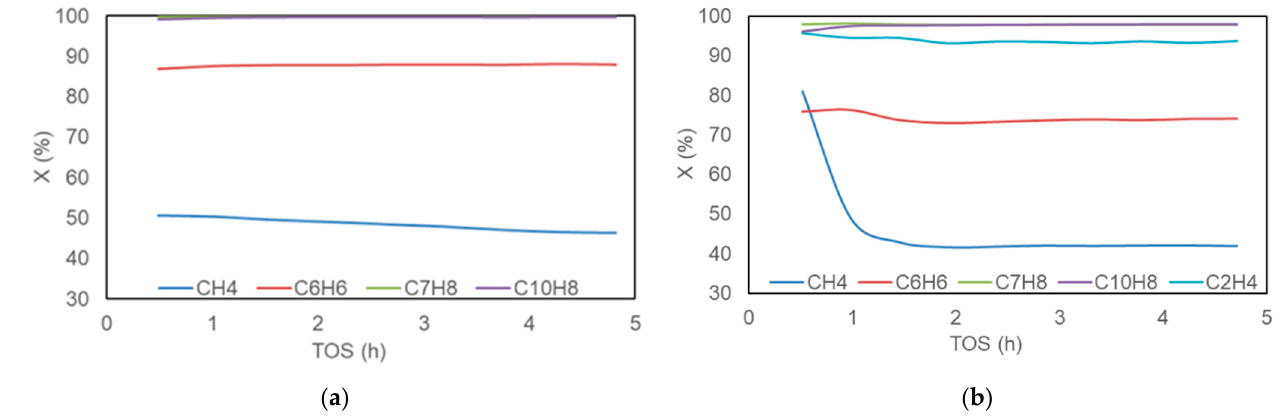
Figure 2. Hydrocarbon conversions as a function of operation time in ( a ) run 5 with rhodium catalyst and ( b ) run 10 with nickel catalyst. Reaction conditions: atmospheric pressure, 20,000 vol-ppm ethylene, 900 °C, TOS 5 h and gas composition 1. Ethylene is not presented in ( a ), as the conversion was 100% through the test run.